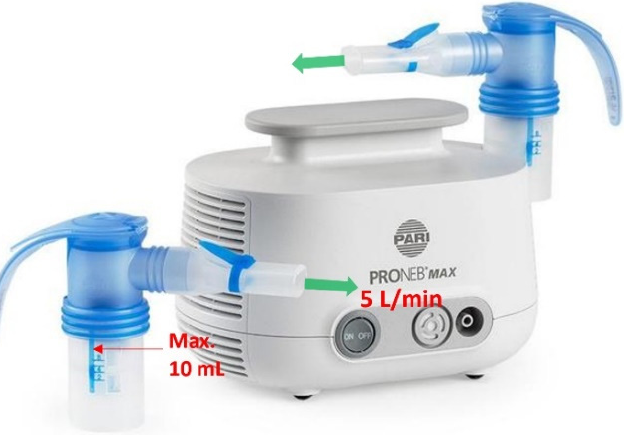
Figure 2. TSI MODEL 3076 Constant Output Atomizer used for aerosolizing heat inactivated SARS-CoV-2 virions. The SARS-CoV-2 containing solution was drawn into the atomizing section vertically through a Poly-Flo ® tubing. As shown in the zoomed-in figure of the atomizing section, the fine aerosolized spray left the atomizer through a silicone rubber tubing and flew into the air sampler while large droplets were removed by impaction on the wall opposite the jet and excess liquid was drained back into the glass bottle through another Poly-Flo ® tubing.